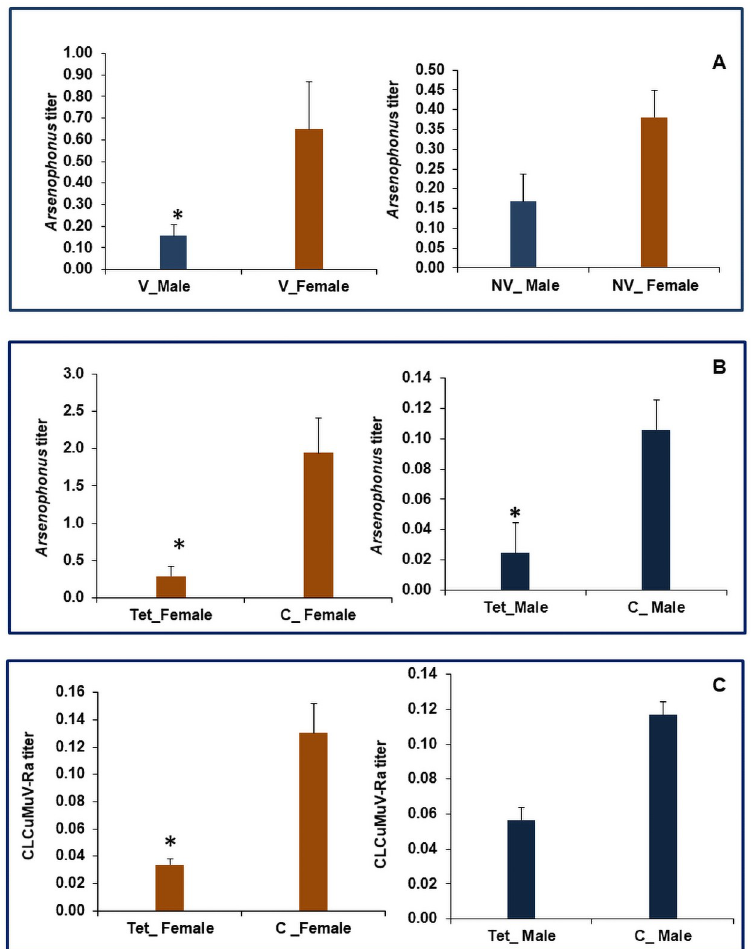
Fig 3. Relative amount of Arsenophonus in, A. viruliferous and non-viruliferous whitefly, B. Tetracycline fed females and males; C. Relative titer of Cotton leaf curl Multan virus -Rajasthanin tetracycline fed female and male whiteflies. The expression level was normalized using B . tabaci β -tubulin as housekeeping gene. The error bars represent the standard deviation (n = 3) and � represents significant differences among male and female whiteflies (P � 0.05, Student’s